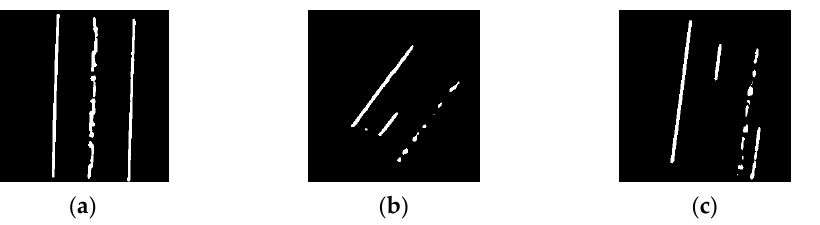
Figure 11. Lane marking misdetection by the pre-trained U-net model for the target domain datasets: ( a ) one-lane highways with dual lane marking at the center, ( b ) dual lane markings at the edge, and ( c ) pair of dual lane markings at the edge.